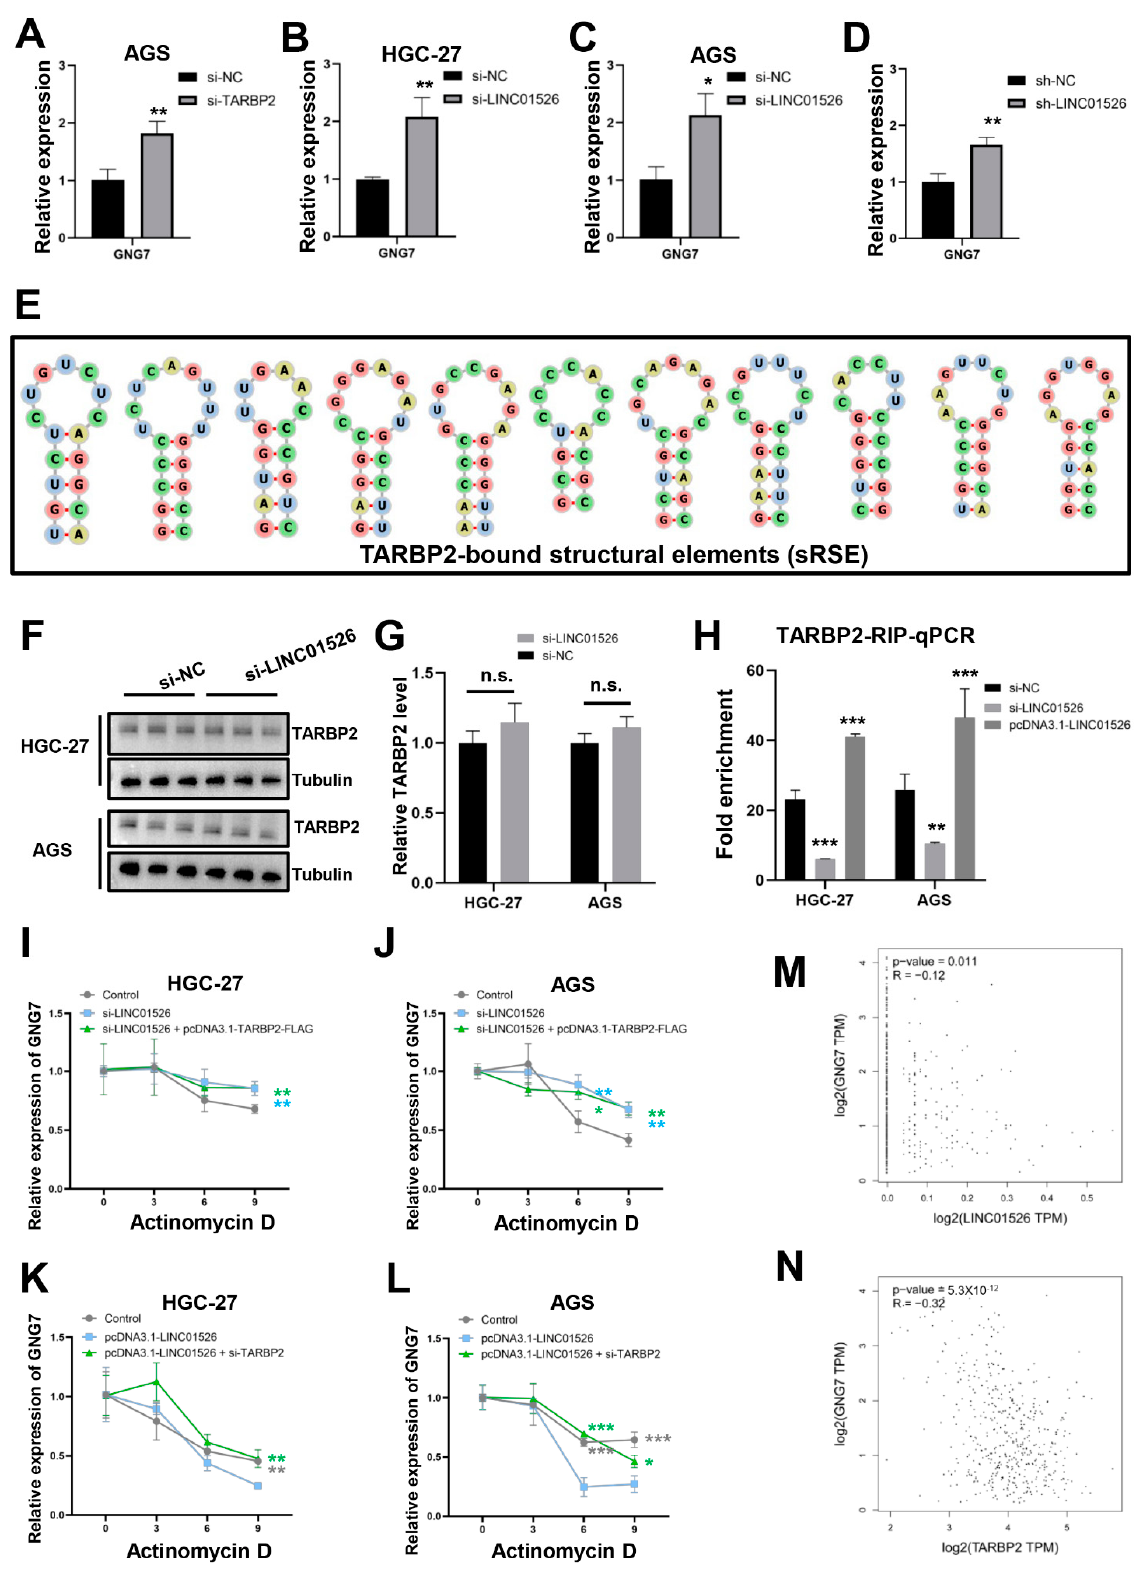
Figure 6. The effect of “Linc01526-TARBP2” on GNG7. ( A ) The mRNA expression levels of GNG7 in AGS cells transfected with si-TARBP2 or si-NC ( n = 3). ( B , C ) The mRNA expression levels of GNG7 in HGC-27 and AGS cells transfected with si-LINC01526 or si-NC ( n = 3). ( D ) The mRNA expression levels of GNG7 in subcutaneous tumors from the empty vector and the sh-LINC01526 group (n =